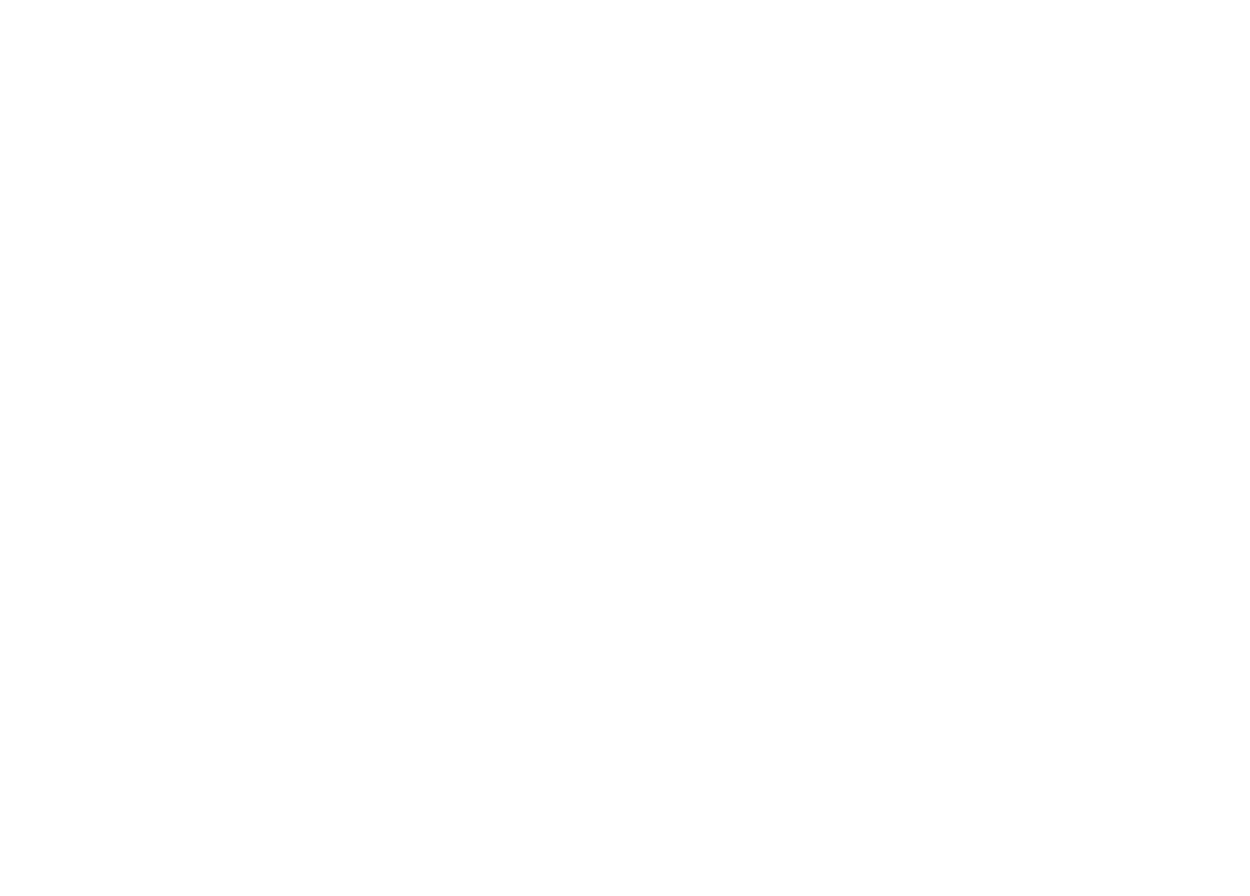
Frontiers in Plant Science |